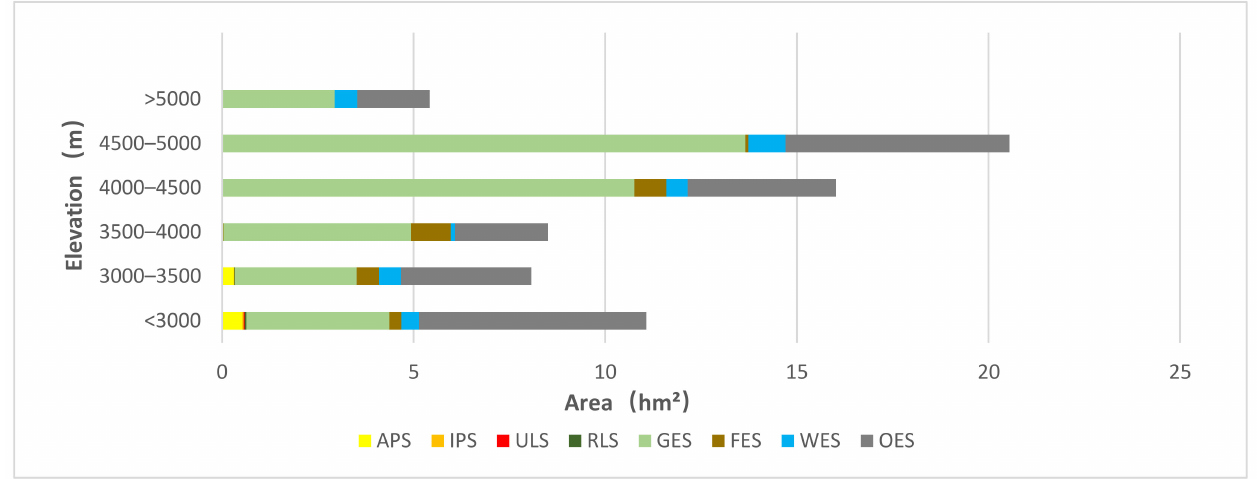
Figure 2. Distribution of PLE space at different altitudes in Qinghai Province,